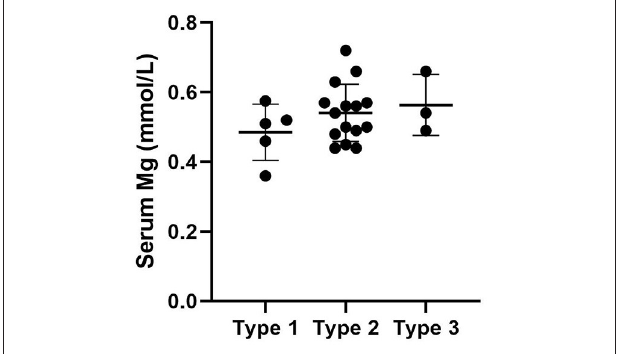
FIGURE 2 | Initial serum magnesium in patients with three types of CNNM2 -related disorders. No significant difference was found. p = 0.3496.